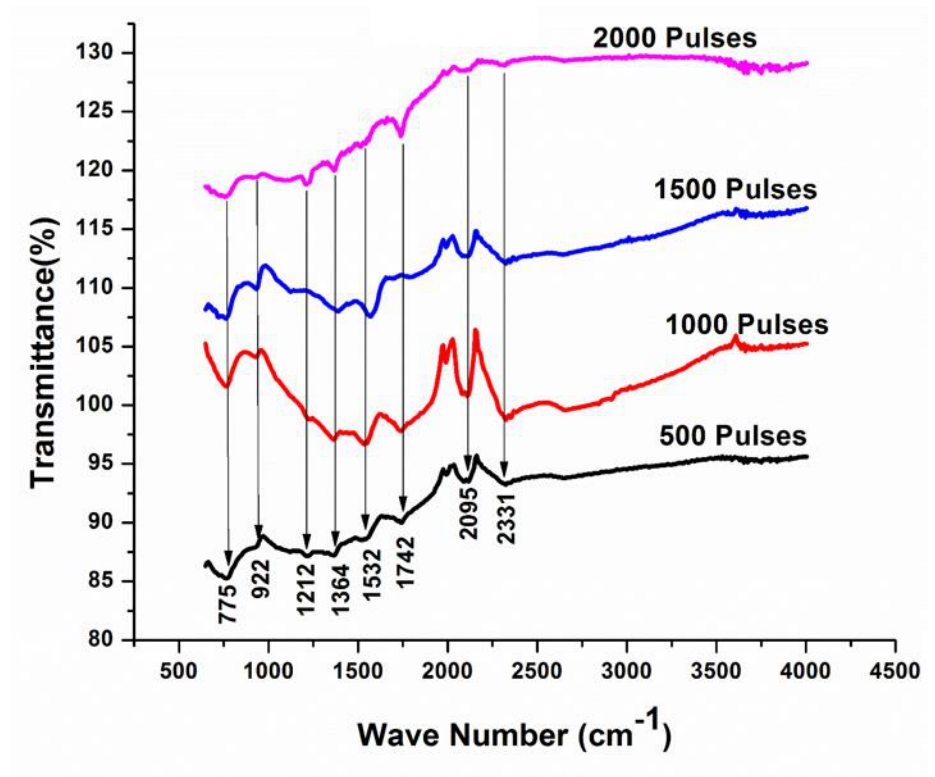
Figure 7. FTIR analysis of laser ablated Cd exposed to 500, 1000, 1500 and 2000 laser pulses at a constant fluence of 3.6 Jcm − 2 in DI water.